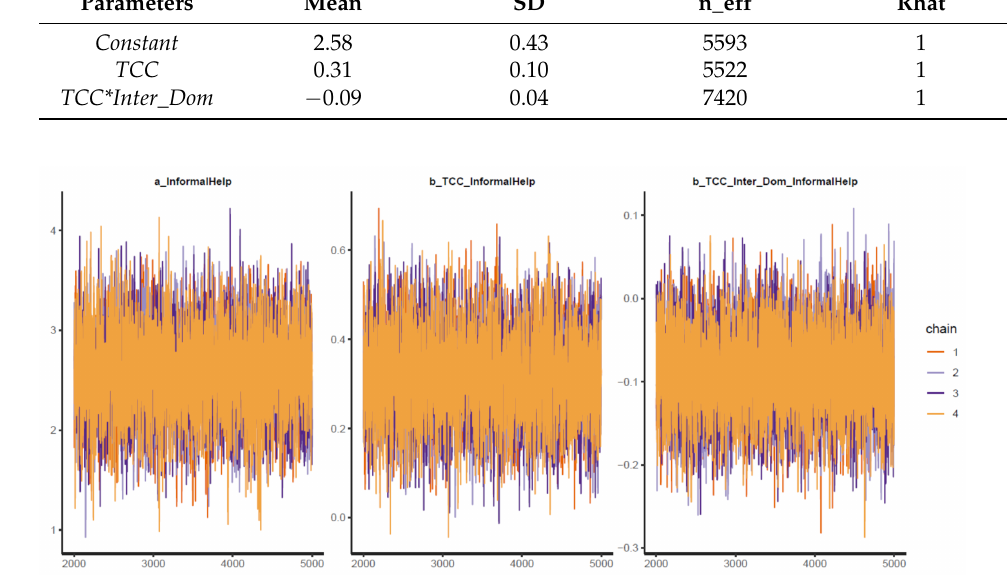
Figure 8. Trace plots for Model 2 (cid:48) s posterior coefficients.